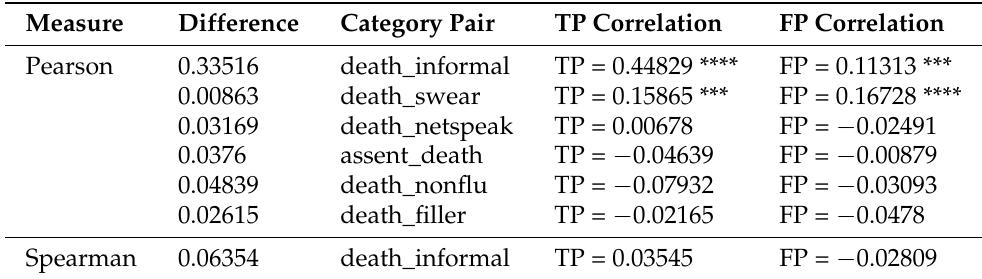
Table 21. Death and Informal language in High.